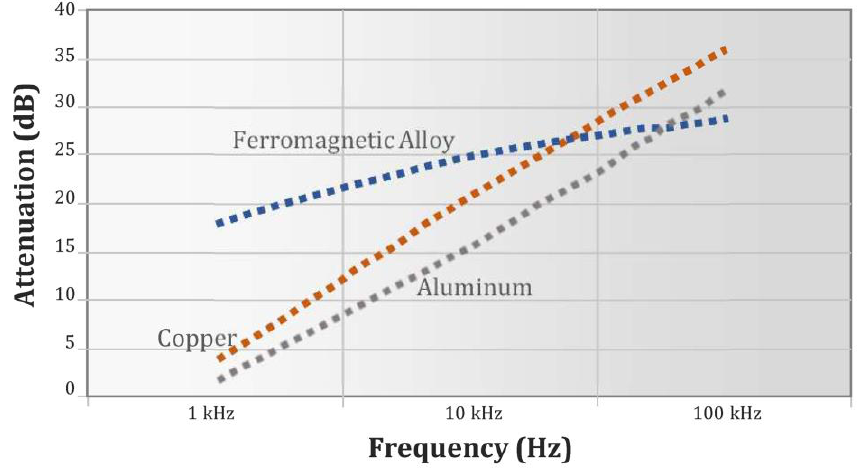
Figure 3. Attenuation performance of metal materials commonly used in EM shielding. Source: Ott, H.W. Noise reduction techniques in electronic systems, John Wiley and Sons. New York, 1976 (by courtesy of John Wiley and Sons).